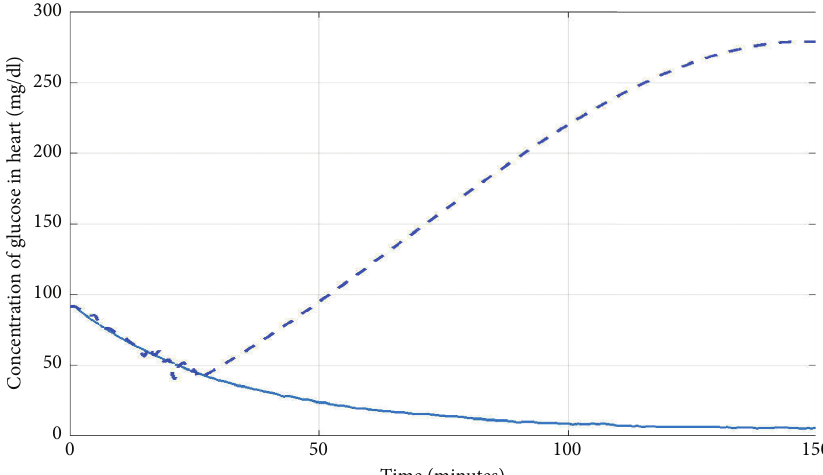
Figure 6: Profile of glucose in heart during euglycemic hyperinsulinemic clamp test. The dashed line shows the type 2 diabetic patients hyperglycemic clamp test, while the solid line shows the same for healthy subjects.